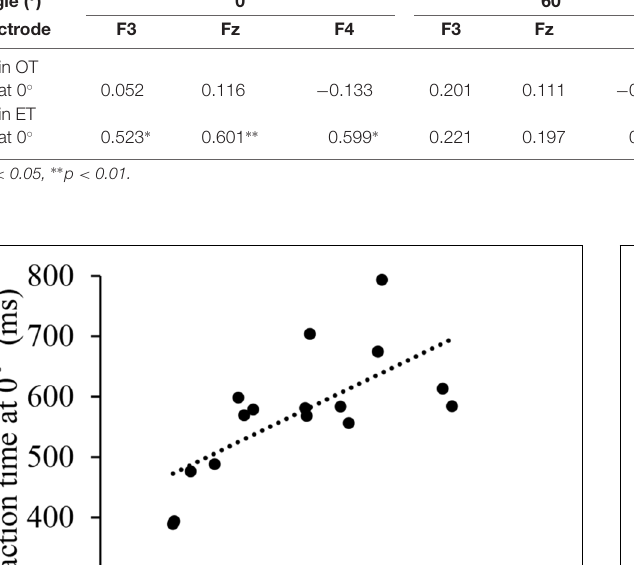
TABLE 3 | Values of correlation coefficients between N2 amplitude and reaction time (RT) at 0 ◦ in OT and ET conditions. Angle ( ◦ ) 0